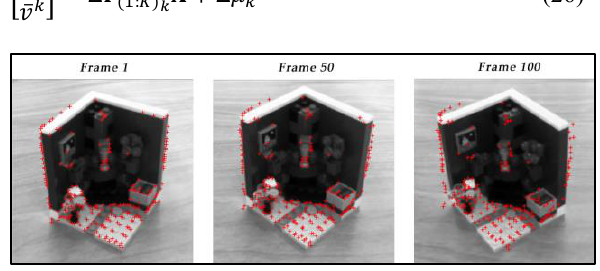
Figure 1. In this tracking result, geometric components dominate the appearance, resulting in an original perspective-skewed tracking